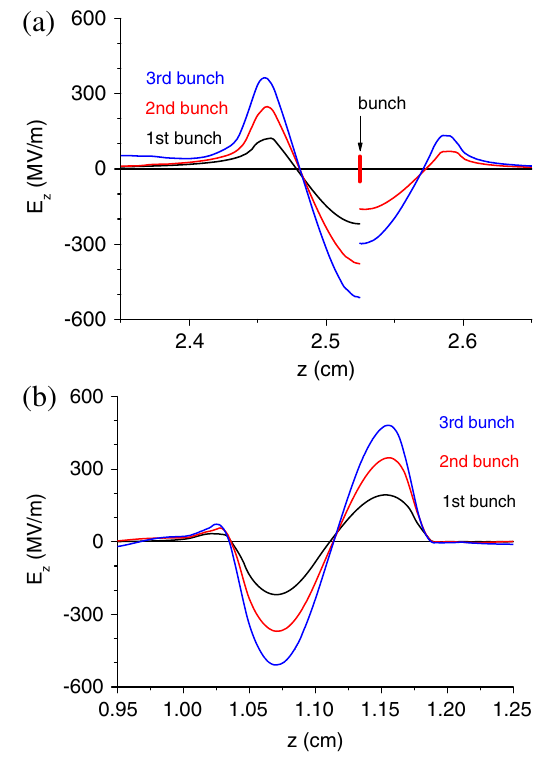
FIG. 14. (Color) The electric field on a beam line of the wake- field of multiple bunches: magnification of peaks of the curve in Fig. 13: (a) 1st peak (near bunch), (b) 2nd